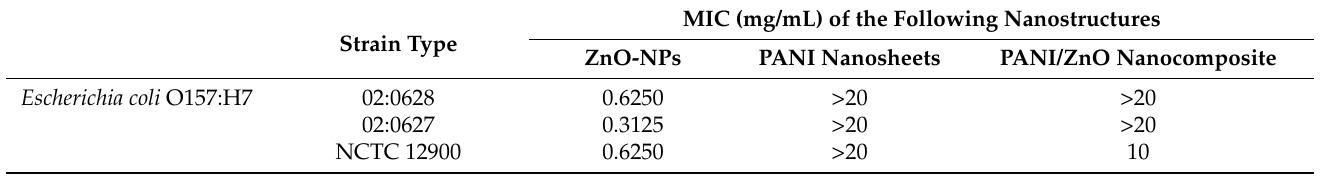
Table 1. MIC of ZnO-NPs, PANI nanosheets, and PANI/ZnO nanocomposite against Escherichia coli O157:H7. MIC (mg/mL) of the Following Strain Type